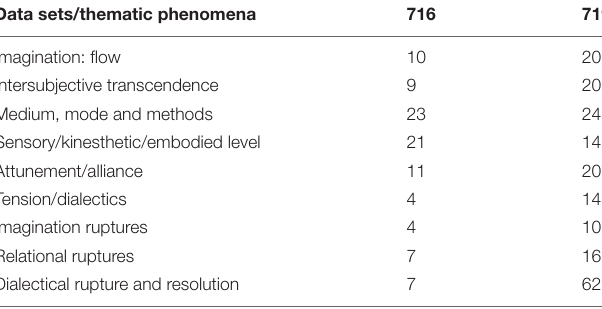
TABLE 3 | Progressive thematic coding frequency over